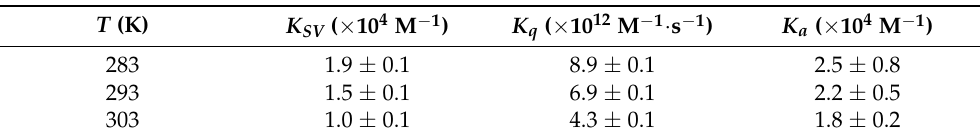
Table 1. Stern–Volmer constant ( K SV ), bimolecular constants ( k q ) and binding constant ( K a ) for the complex NBD and PPL at 283, 293 and 303